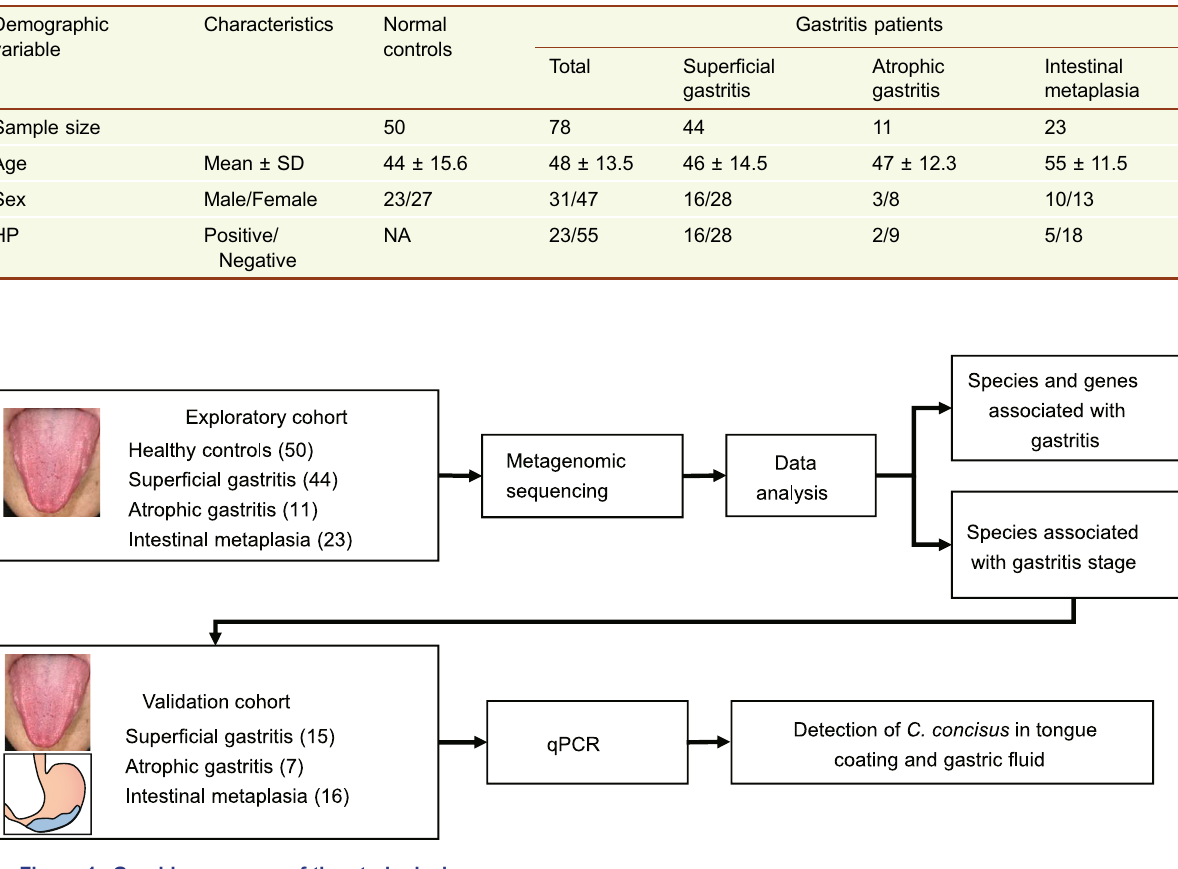
(Fig. 2B). De novo sequence assembly and gene clustering on tongue coating samples identi fi ed ∼ 1.9 M non-redundant putative genes. The genes were annotated to 5,377 KOs and classi fi ed according to functions (Fig. 2C and Table S4).